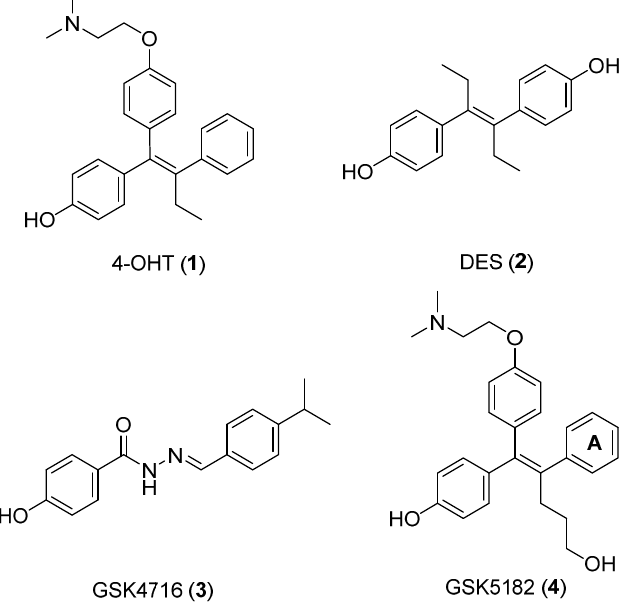
Figure 1. The ERR γ ligands. 4-OHT ( 1 ): ER α antagonist/ERR γ inverse agonist. DES ( 2 ): ER α agonist/ERR γ inverse agonist. GSK4716 ( 3 ): selective ERR γ agonist. GSK5182 ( 4 ): selective ERR γ inverse agonist.